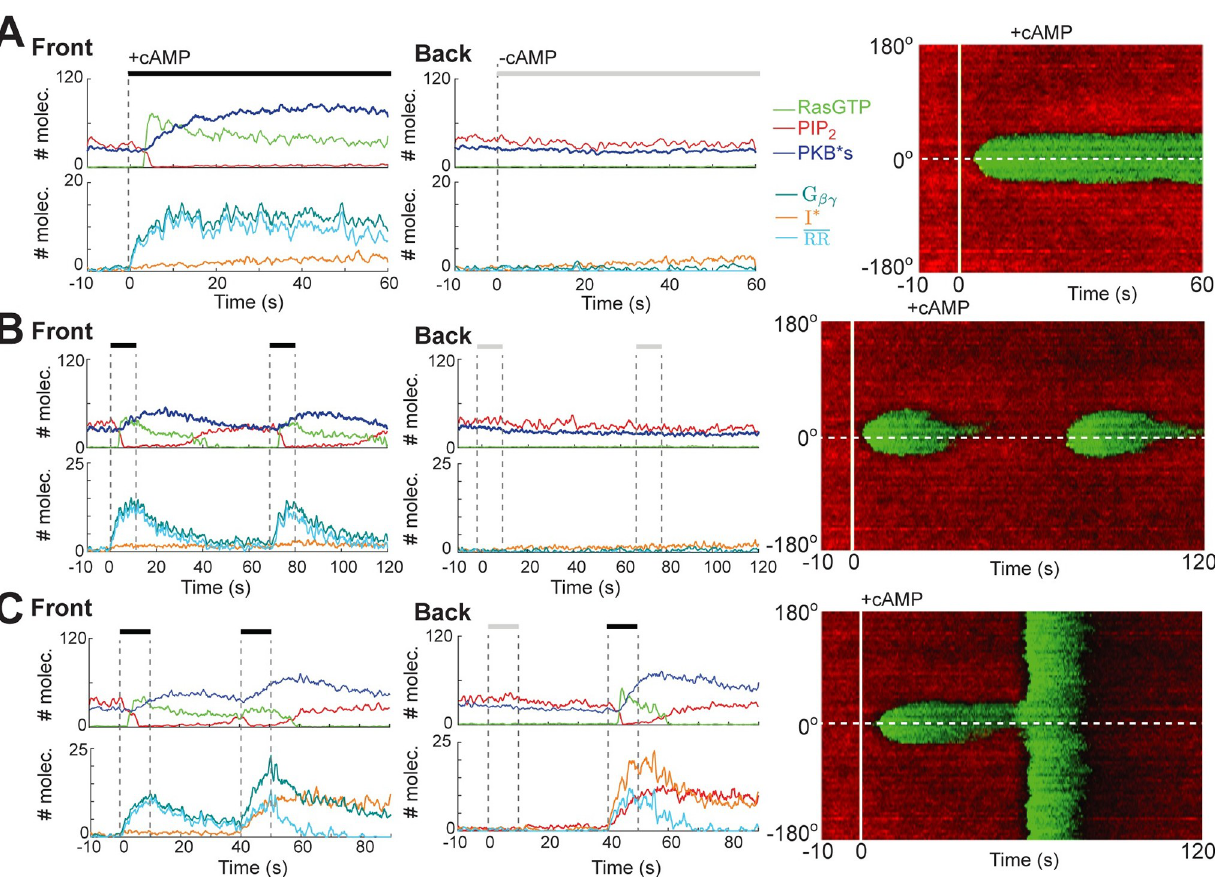
Fig 6. Response to combinations of temporal and gradient stimuli. (A–C) Shown are the temporal profiles of RasGTP (green), PIP 2 (red), PKBs � (blue), G α 2 (teal), G βγ (orange) and basal subtracted normalized RR ( RR , cyan) at single nodes at the front and back of the cell. The kymographs (right) show RasGTP (green) and PIP 2 (red). Solid white line denotes when the gradient was applied, and the dashed line shows the needle position (front). Whereas Panel A shows the response to a single gradient, B and C show the response to two gradient stimuli with a delay of 60 s (B) and to a gradient stimulation followed by a global one